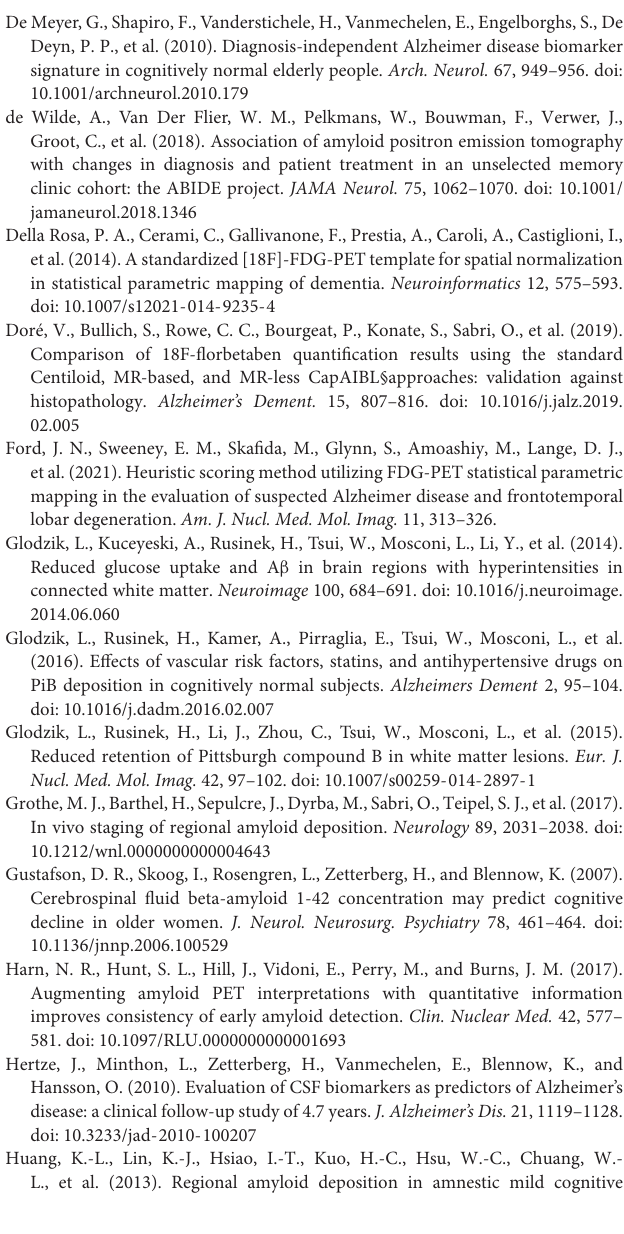
Supplementary Figure 1 | Receiver operating characteristic (ROC) curves generated for the anterior cingulate (A) , posterior cingulate (B) , and precuneus (C) regions. An optimal z-score cutoff for each region was calculated using Youden’s